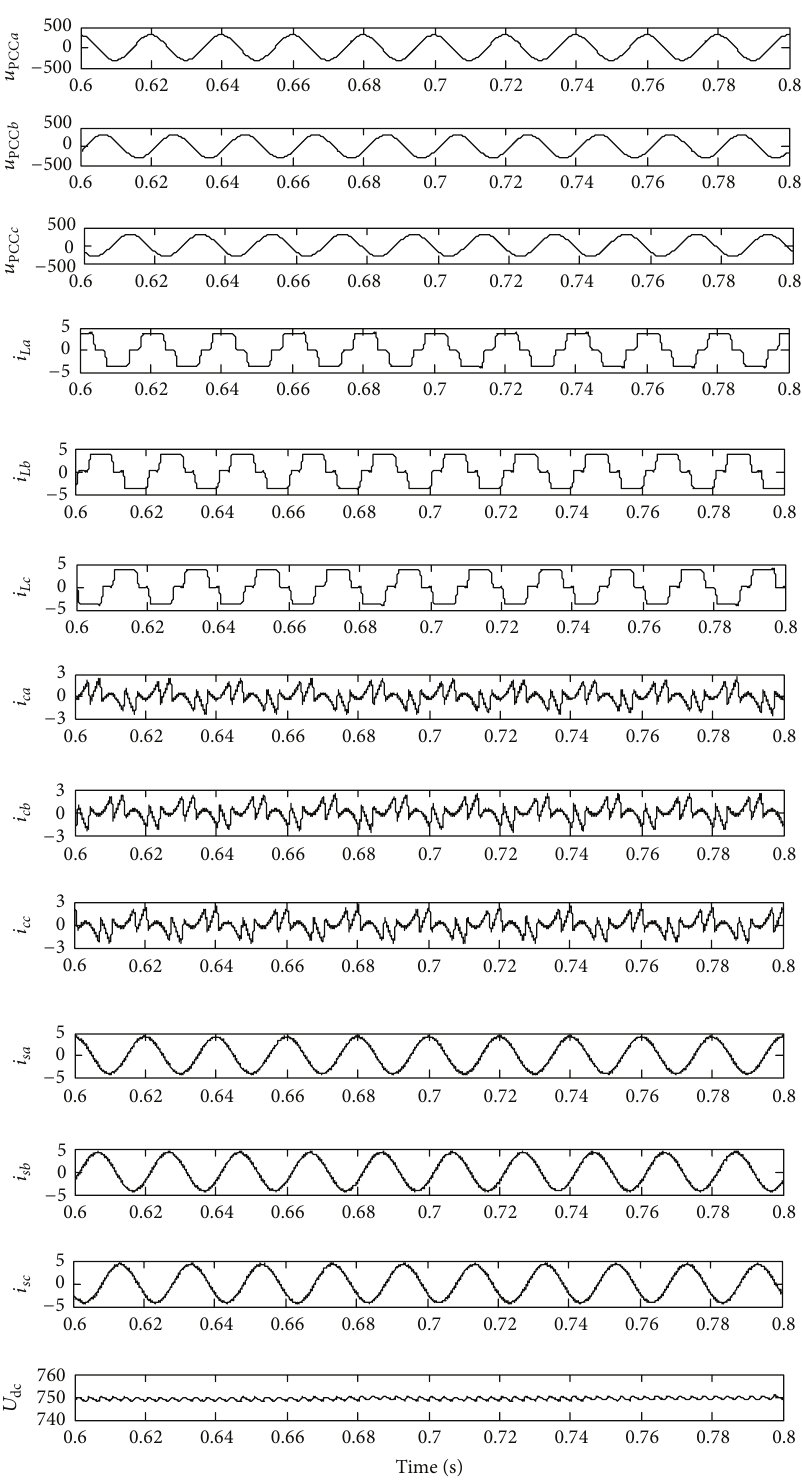
Figure 13: The simulation results using first-order Lagrange